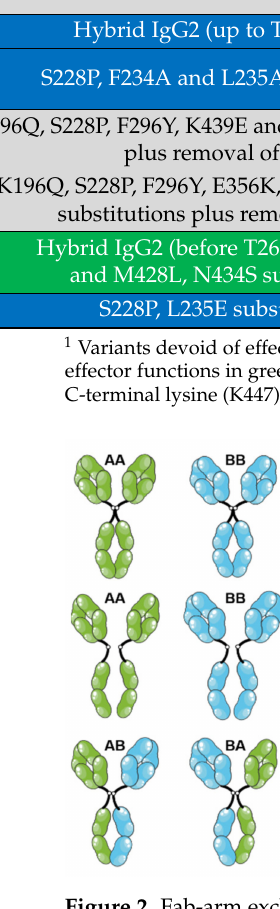
Figure 2. Fab-arm exchange of IgG4. Each IgG4 could dissociate in two parts at the level of the hinge region and of the Fc region, resulting in two half-IgG4 (one heavy chain associated with its